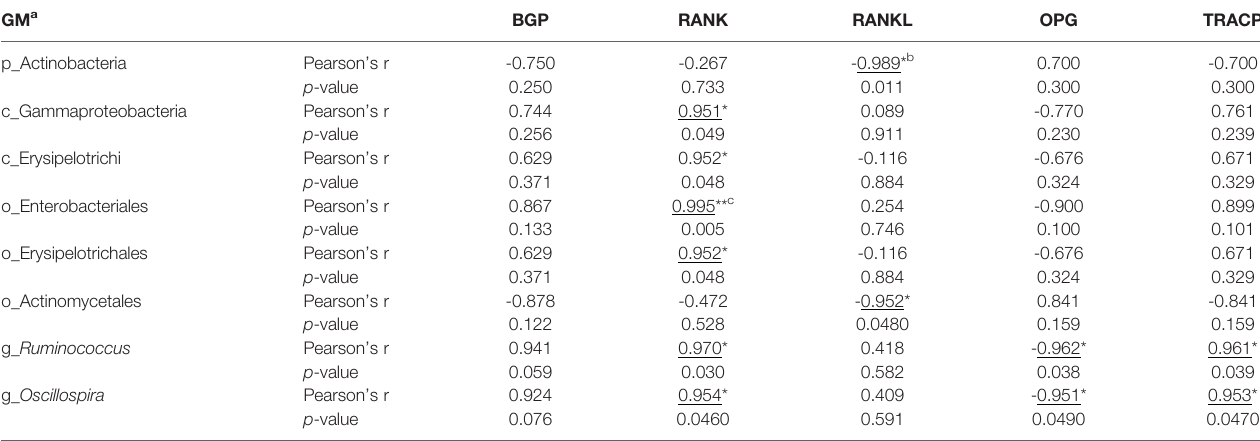
TABLE 1 | Pearson analysis of the correlations between GM and serum biomarkers probably associated with bone metabolisms. GM a BGP RANK RANKL OPG TRACP p_Actinobacteria Pearson ’ s r